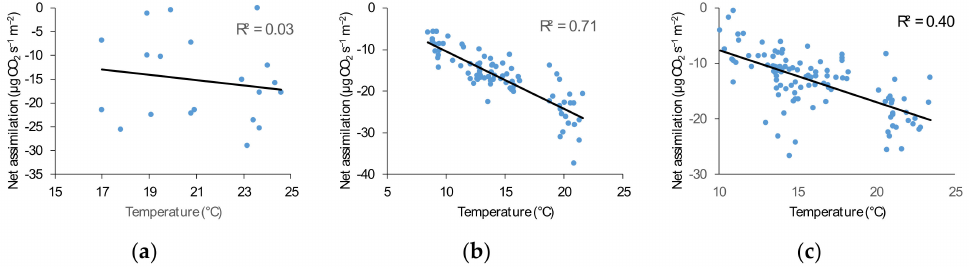
Figure A2. Nighttime correlations between shoot net photosynthetic assimilation and shoot chamber temperature for ( a ) 2014; ( b ) 2015 (flattened shoot); and ( c ) 2015 (undeformed